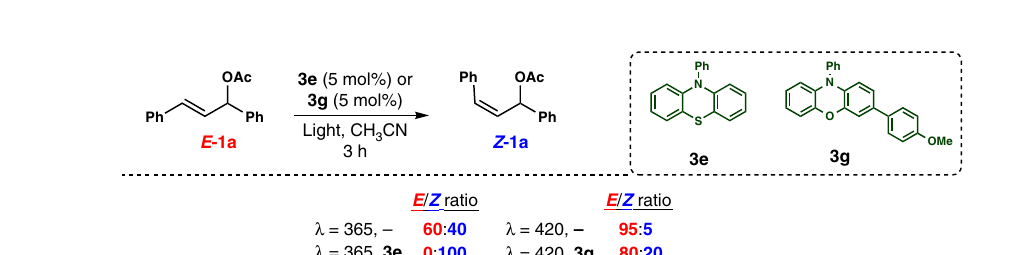
Fig. 2 Isomerization studies. Isomerization proofs of E - 1a under different catalysts ( 3e and 3g ) and different irradiation